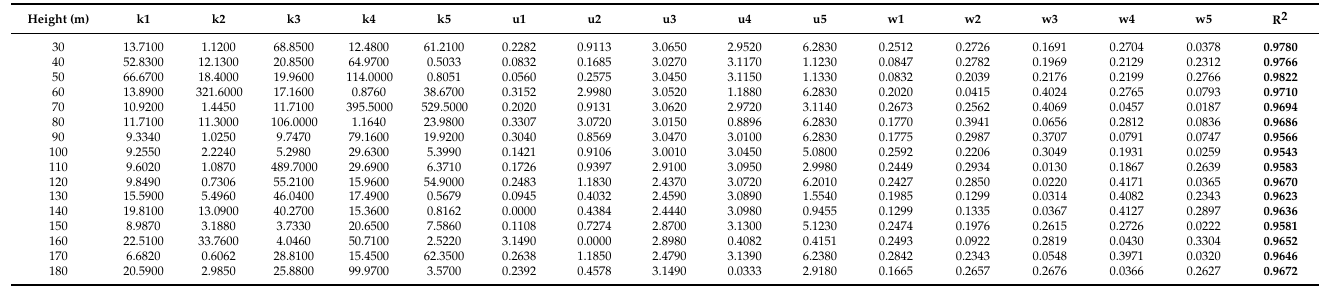
Table 6. Parameter fitting value of f ( θ )